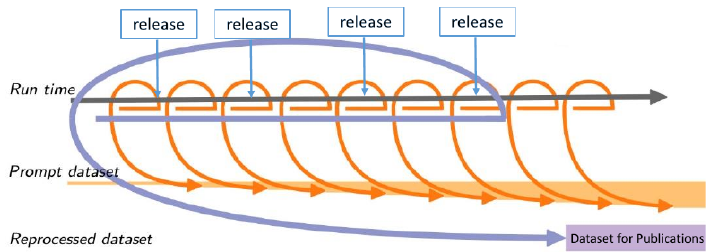
Figure 1. The rough scheme of prompt processing vs. major reprocessing. Releases are basf2 software versions, usually minor or patch release versions, which are requested whenever calibration code is updated. Therefore the total prompt dataset will contain data processed using several basf2 versions. A new reprocessed dataset is made every ∼ 6 months using old + new data and the best calibration constants